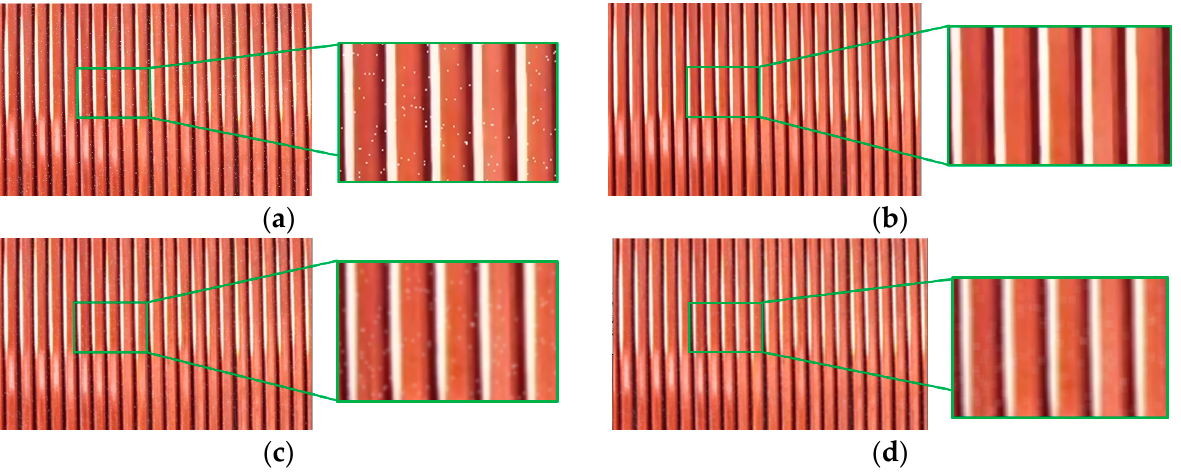
Figure 7. Median filter effect: ( a ) images containing noise; ( b ) median filtering; ( c ) mean filtering; ( d ) Gaussian filtering.